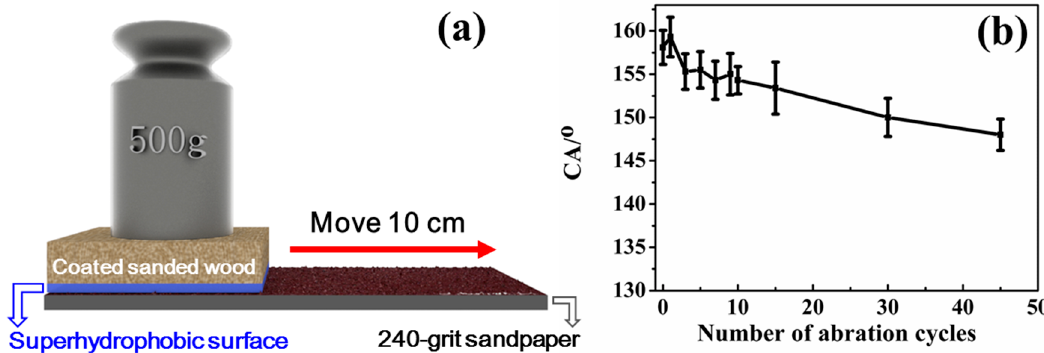
Figure 5. ( a ) Illustration of the abrasion resistance test for the superhydrophobic surface. ( b ) Water CAs as a function of the number of abrasion cycles.